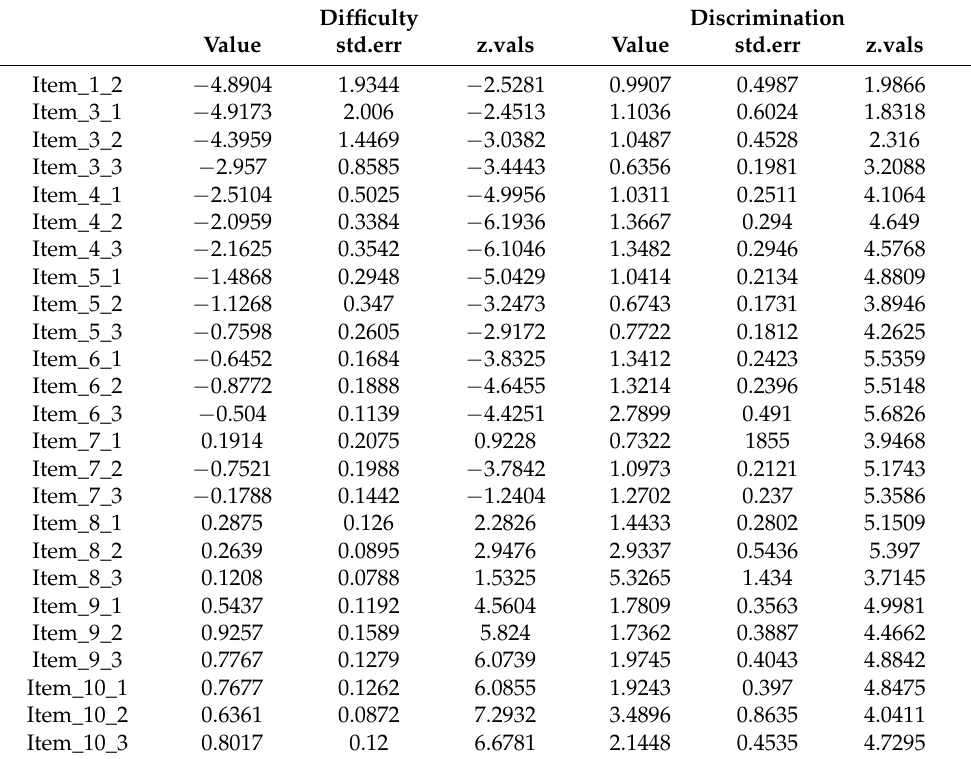
Table 2. Summary of the 2PL model parameters.